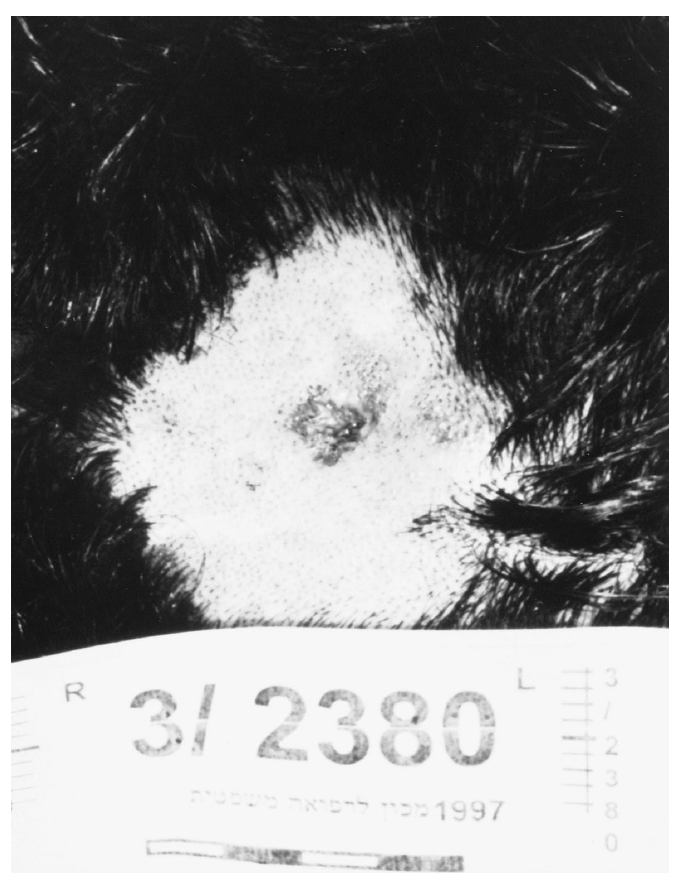
FIGURE 7 . Gunshot wound at the head after